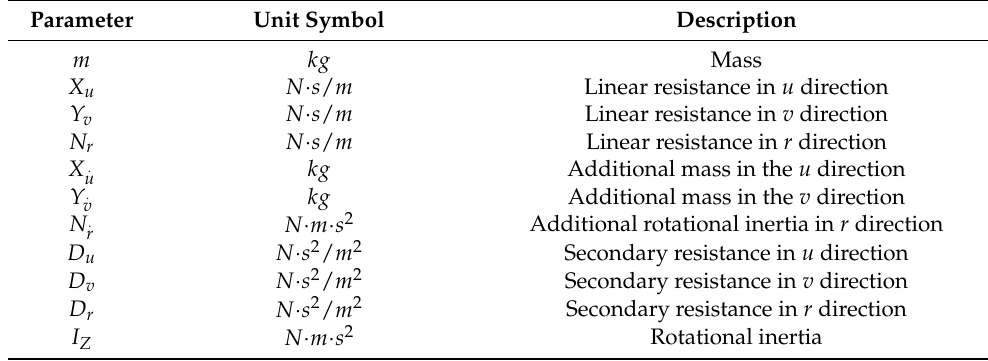
Table 2. Correspondence table of meanings of kinetic model parameters. Parameter Unit